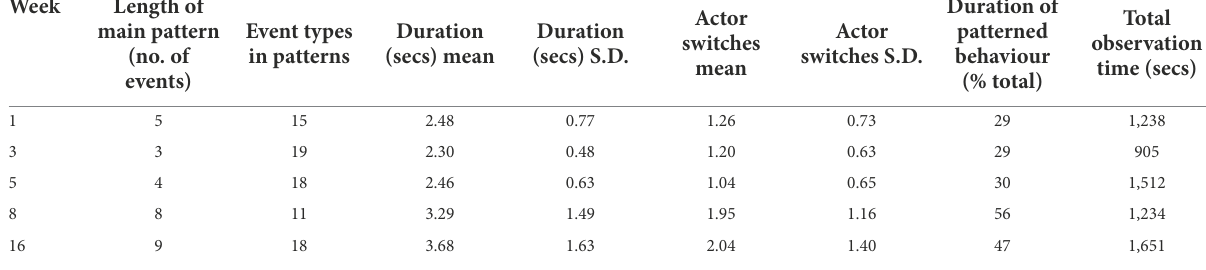
TABLE 5 Group 2: summary of pattern data by rehearsal. Week Length of main